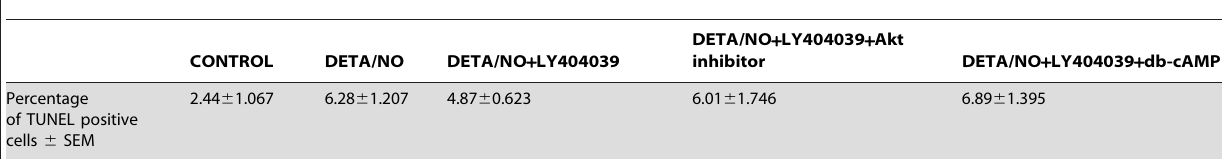
Table 1. Akt activity and cAMP reduction mediate the protective effect of mGluR3 on DNA fragmentation induced by NO.